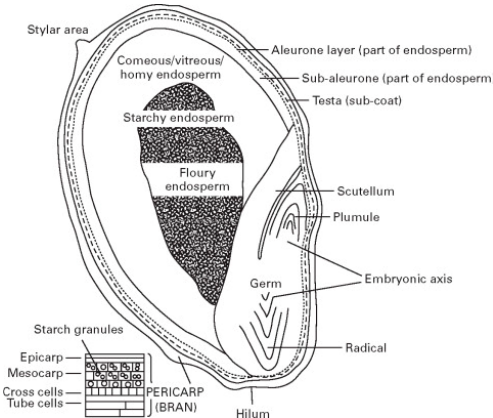
Figure 2. Sorghum grain structure. Image reproduced after Taylor and Emmambux [13] with permission from Elsevier.